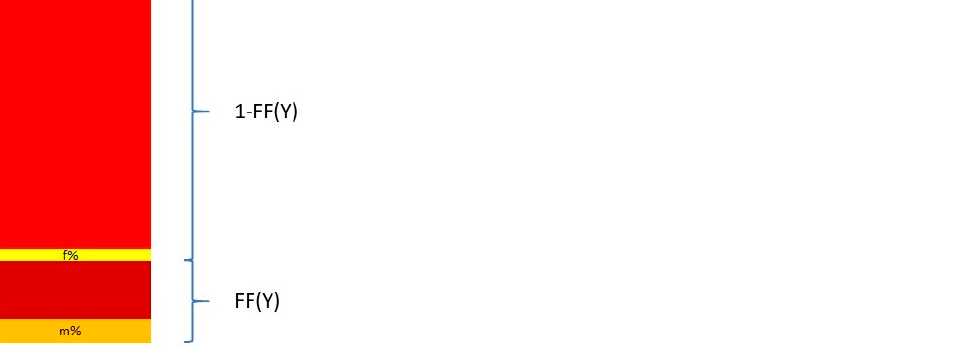
Figure 3. Calculation of the FF based on proportion of Y chromosome reads mapping to the Y chro- mosome and the pseudo-autosomal region of the X